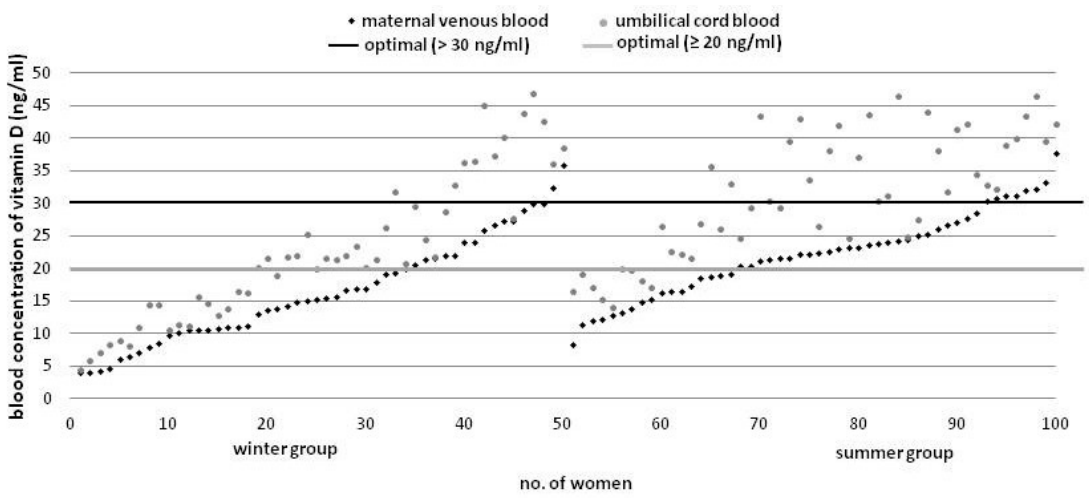
Figure 2. Vitamin D concentration in the mother-infant blood sets by season (ascending order).